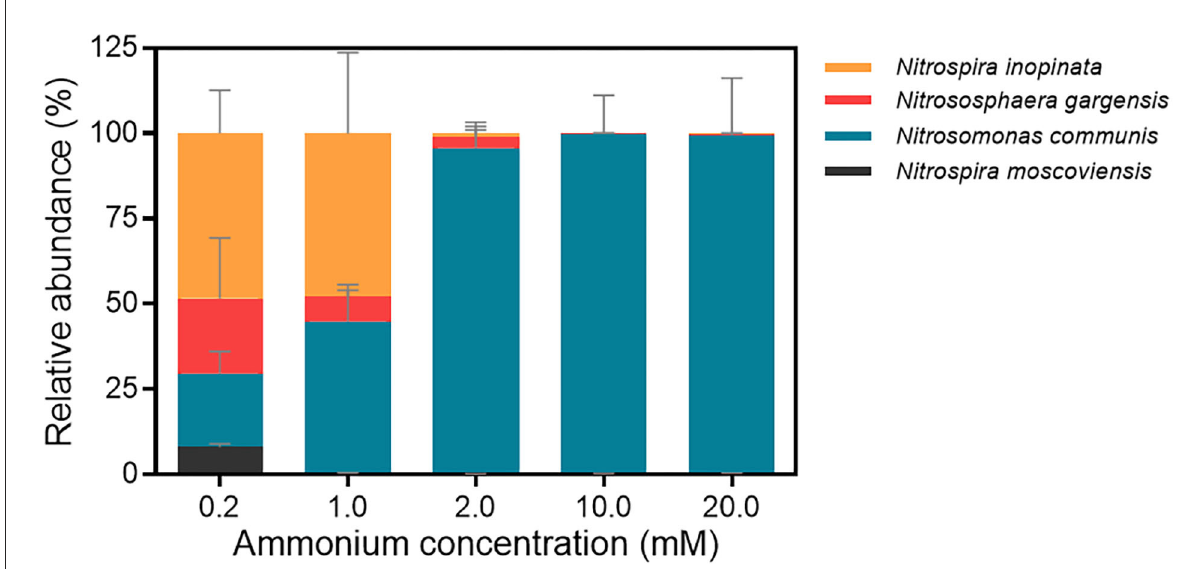
FIGURE3 Relative abundances of four nitrifiers in the N4 community at end time point analyzed by qPCR . a. 0.2mM; b. 1mM; c. 2mM; d. 10mM; e. 20mM. The end time point of each treatment was chosen when ammonium was completely consumed, or nitrification ceased. Data are presented as mean ± SE ( n =